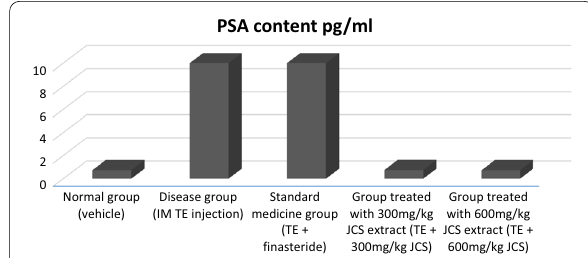
Fig. 3 PSA level in blood samples, normal group, disease group, standard medicine group, groups treated with 300 and 600 mg/kg JCS extracts. JCS extracts significantly different from disease group ( p <